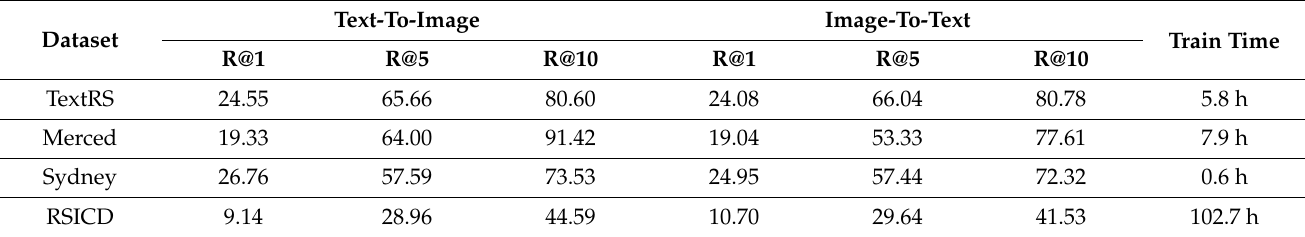
Table 3. The retrieval performance in terms of R@K on different